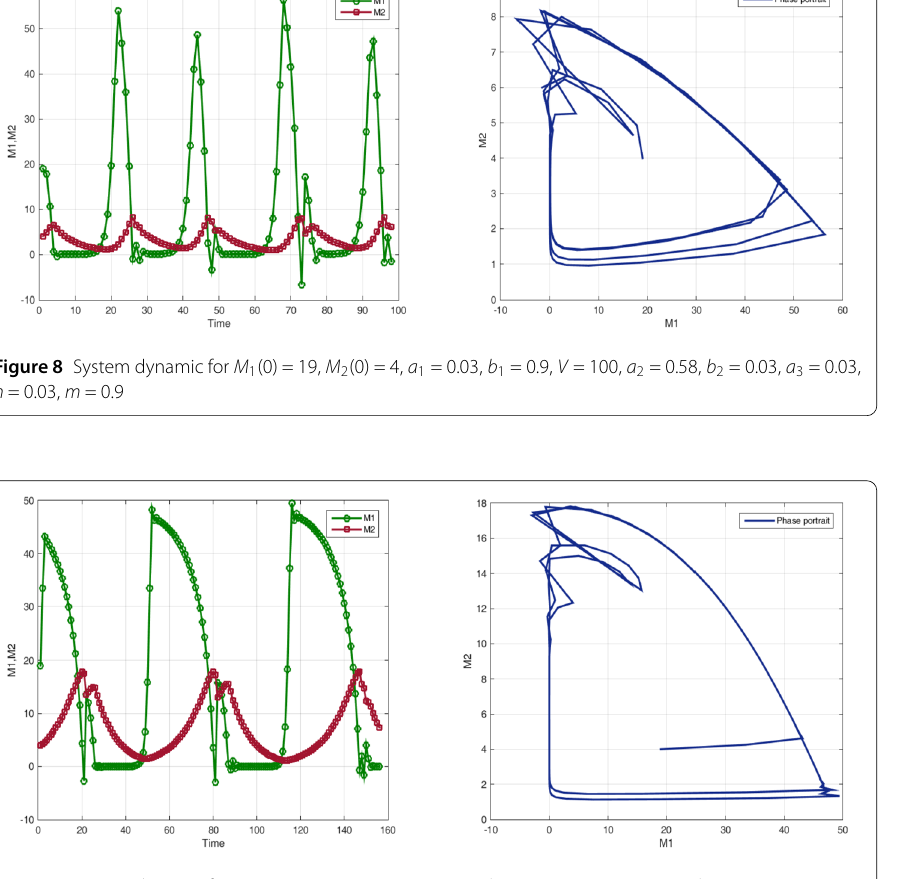
Figure 9 System dynamic for M 1 (0) = 19, M 2 (0) = 4, a 1 = 0.03, b 1 = 0.9, V = 100, a 2 = 0.3, b 2 = 0.03, a 3 = 0.13, n = 0.7, m =